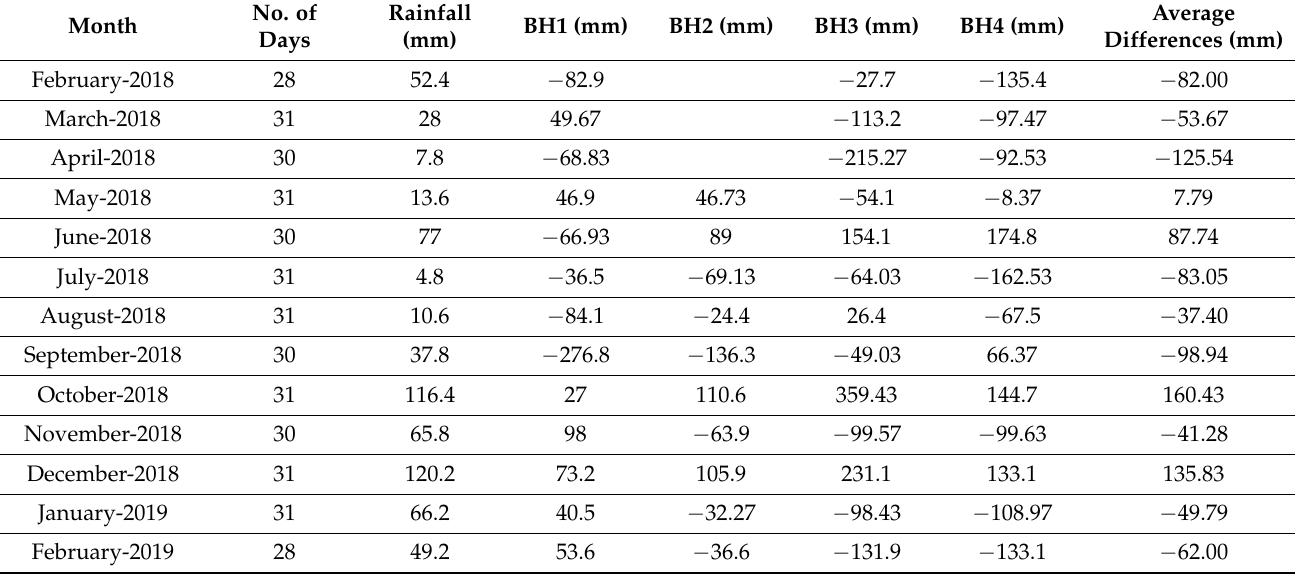
Table 2. Monthly differences in the WTD ( − indicates WTD increase and + indicates WTD